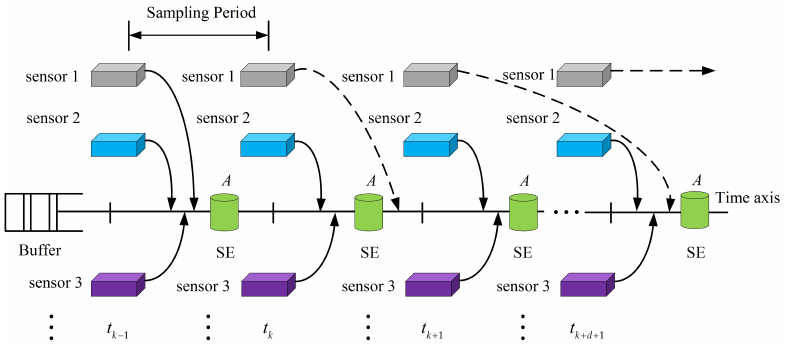
Figure 1. Schematic diagram of the system with multiple-step, randomly delayed measurements.